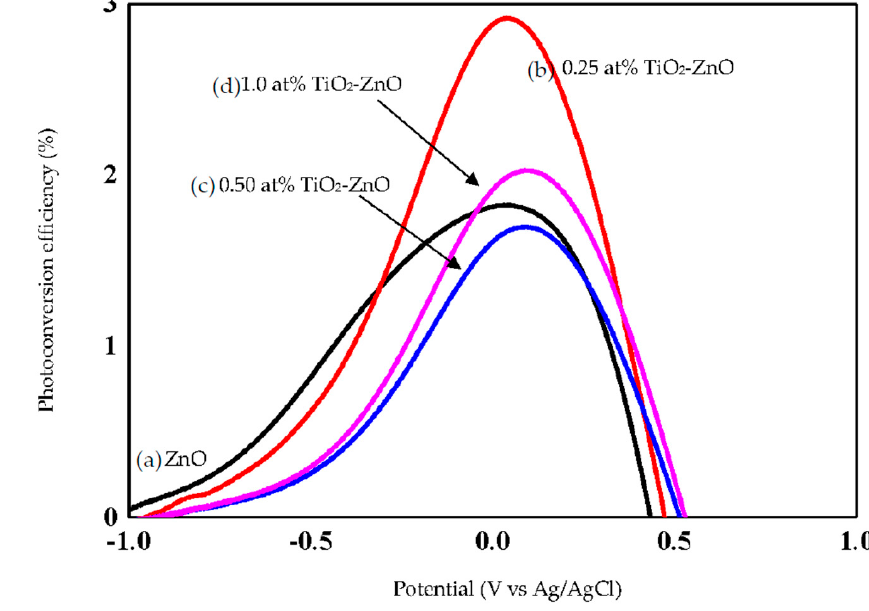
Figure 13. Photoconversion efficiency of ( a ) ZnO; ( b ) 0.25 at % TiO 2 -ZnO; ( c ) 0.50 at % TiO 2 -ZnO; and ( d ) 1.0 at % TiO 2 -ZnO under UV illumination.